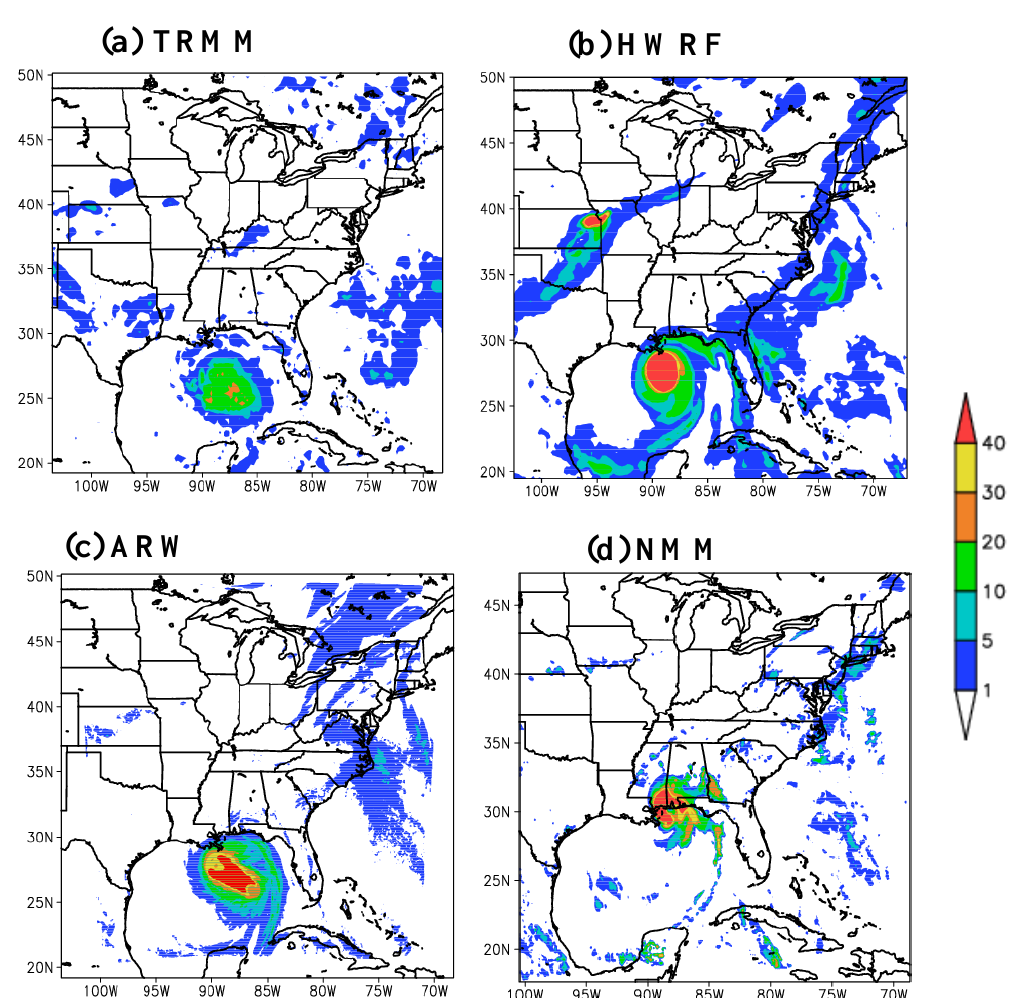
Figure 8. Model predicted 24-hour accumulated rainfall (cm) during the period from 0000 UTC of 28 to 0000 UTC of 29 August 2005 along with corresponding observed rainfall (cm) from